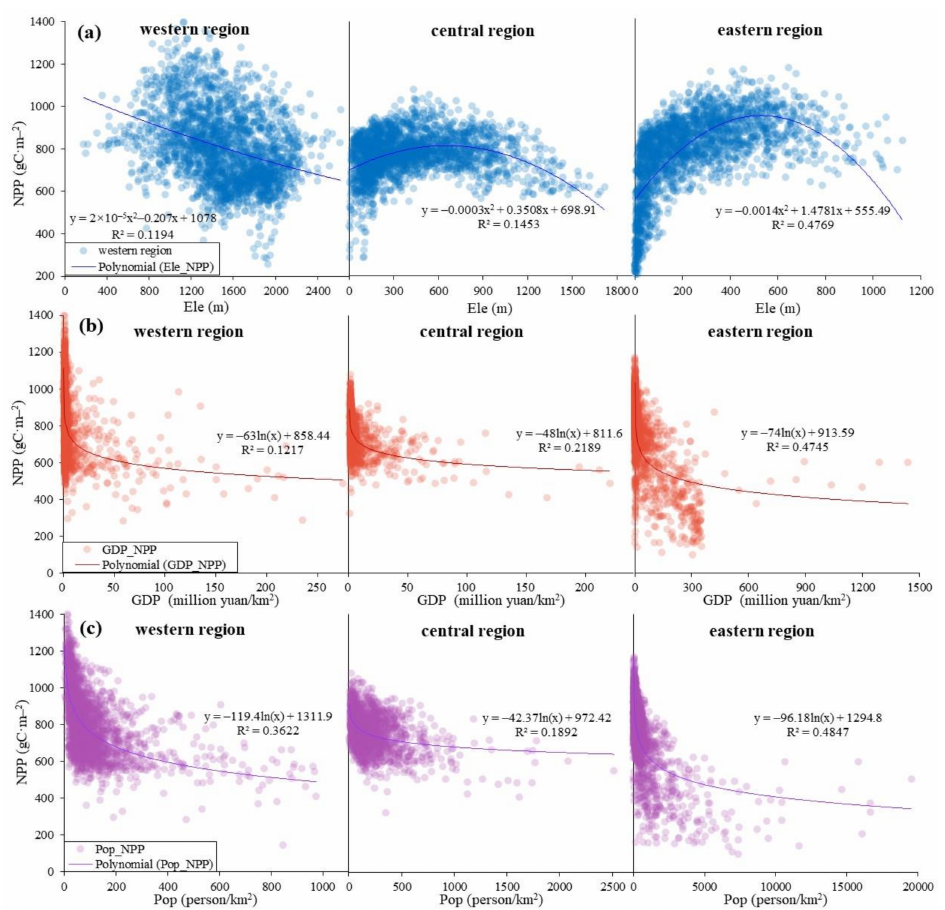
Figure 7. Correlation between mean NPP and ( a ) Ele, ( b ) GDP, and ( c ) Pop in the three regions. The NPP increases in the central region from the center to the west, east, and